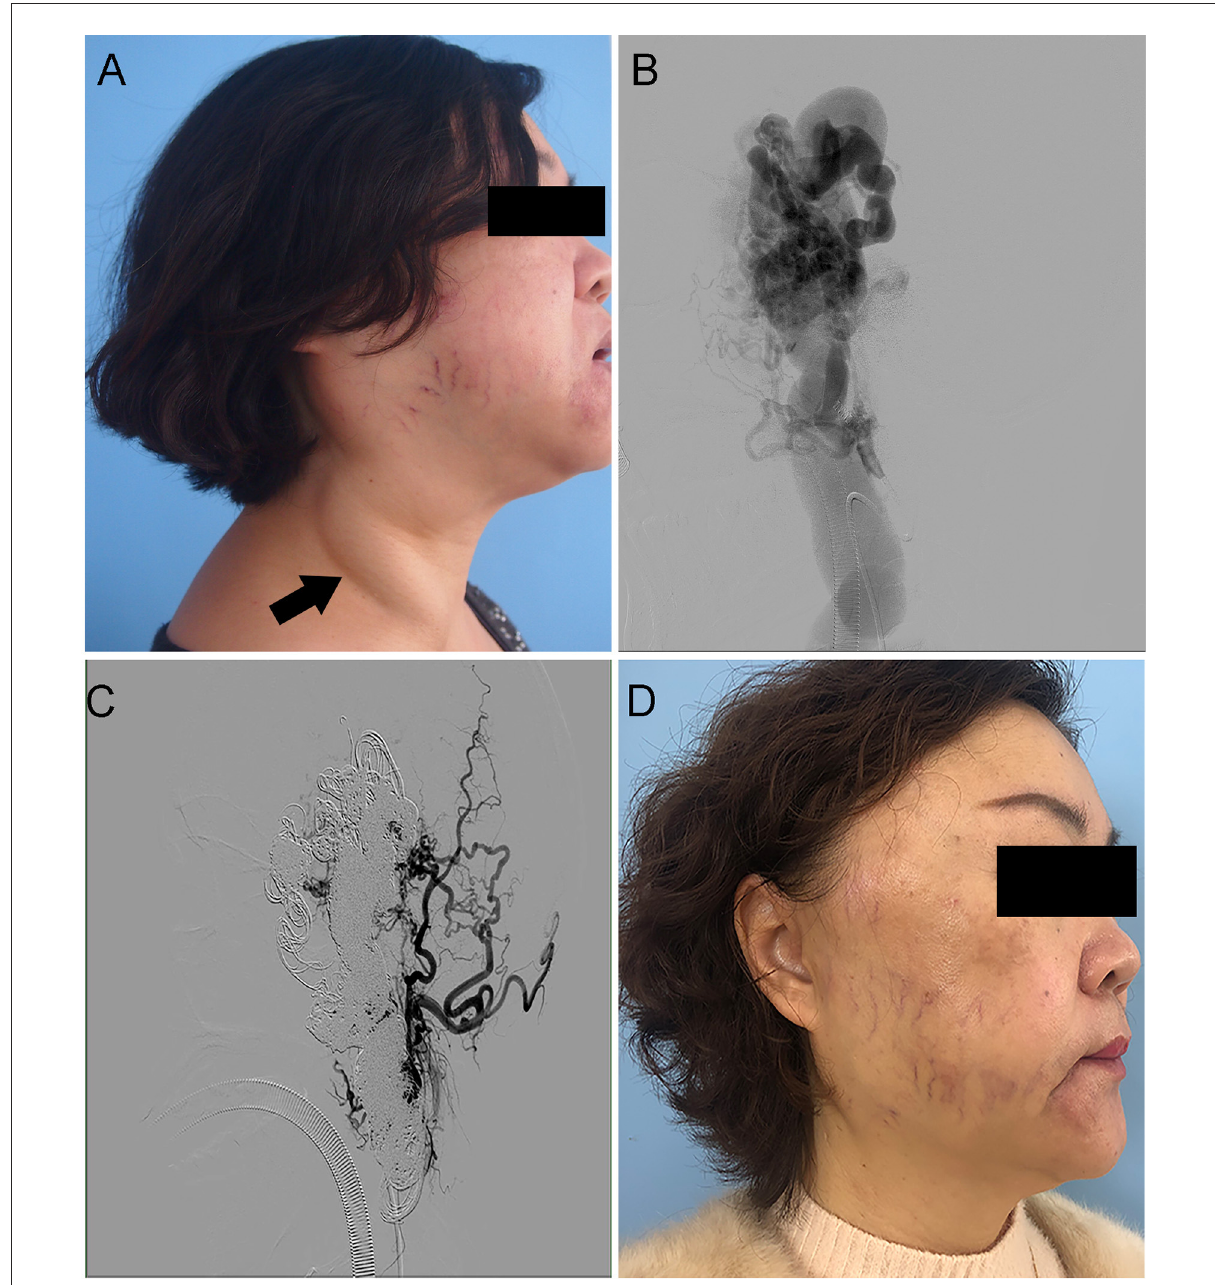
FIGURE3 Case 6. An HOCF patient with right neck arteriovenous malformations (AVMs). (A,B) Preoperative photographs show giant right-neck AVMs with pulsatile masses. (C,D) Photographs taken 36 months after absolute ethanol and coil embolization embolotherapy of AVMs under the assistance of large neck reflux vein ligation show shrinkage of the neck AVMs without